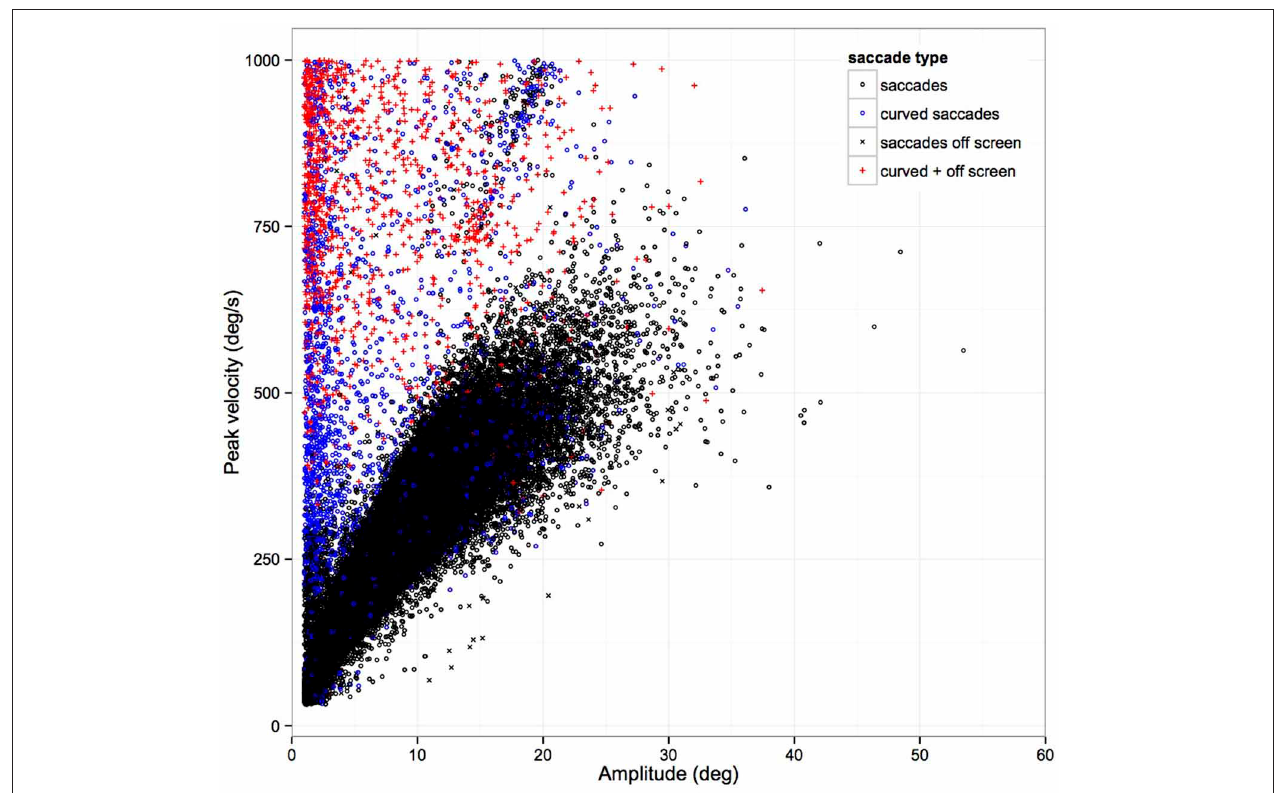
FIGURE 2 | Main sequence, peak velocity, and amplitudes of 73 subjects. Peak velocity increases with amplitude of saccades. There are subjects revealing saccades with high velocities and small amplitudes lying outside of the main sequence. These data points represent portions of the gaze trajectory where arc length exceeds cord length. These represent curved